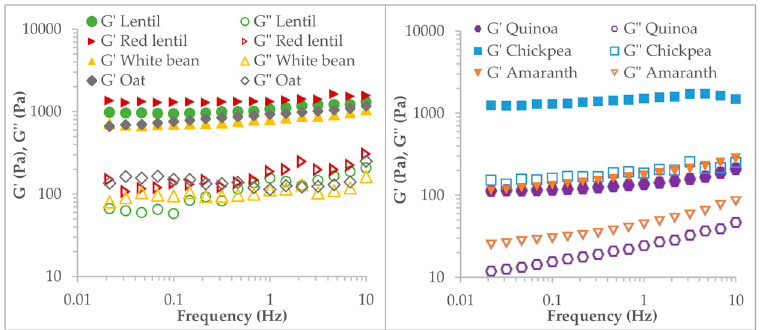
Figure 3. Mechanical spectra of fl our pastes (10%). G ′ ( fi lled symbols) and G ″ (open symbols). Table 5. Mean values of the storage modulus (G ′ ), loss modulus (G ″ ), and loss tangent (tan δ ) values at 1 Hz of the fl our pastes. Standard deviation in brackets .